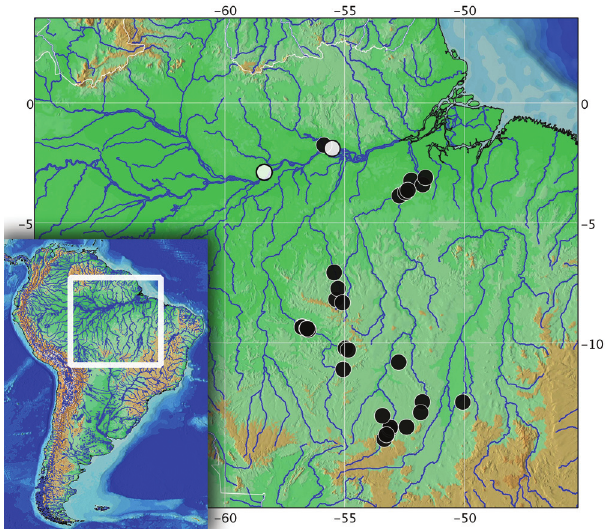
Fig. 5. Distribution of Astyanax multidens in the rio Amazonas basin. White circle represent the type